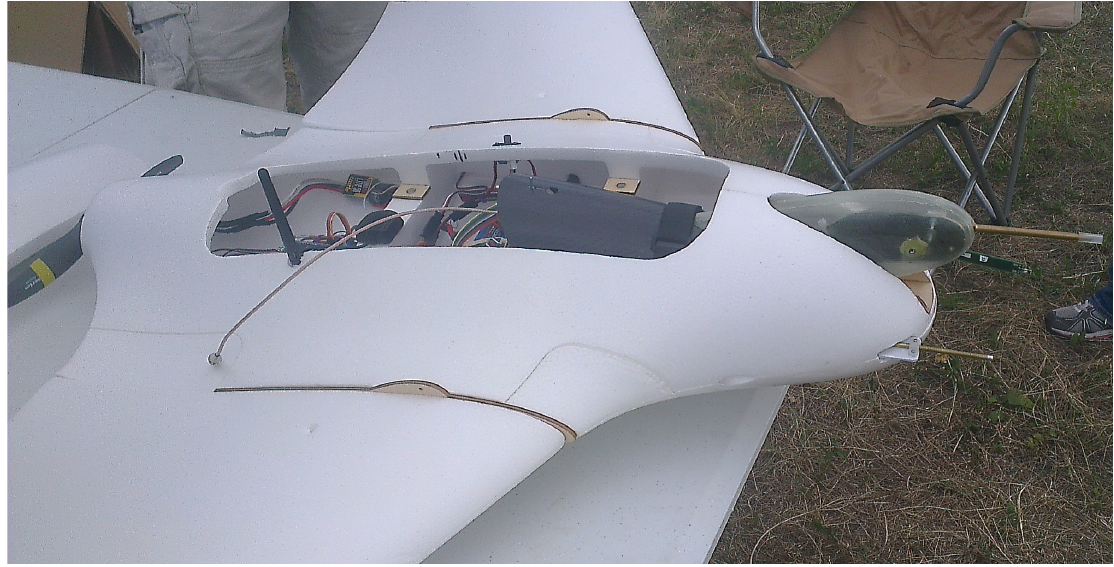
Figure 3. Research UAV Skywalker X8 with the MASC measurement